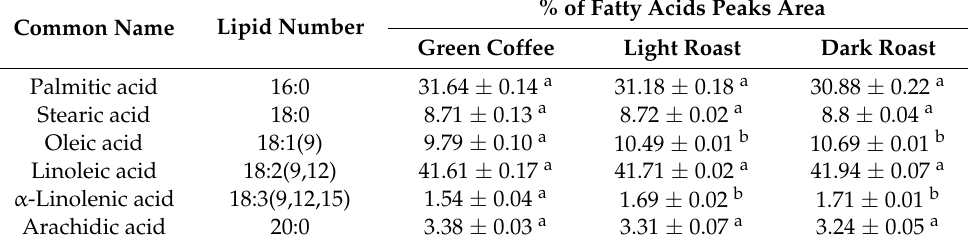
Table 5. The fatty acids profile in coffee fat sample. ( ± ) standard deviation (SD) from triplicate measurements. Data denoted by the same letter are not statistically different ( α = 0.05) in terms of roasting